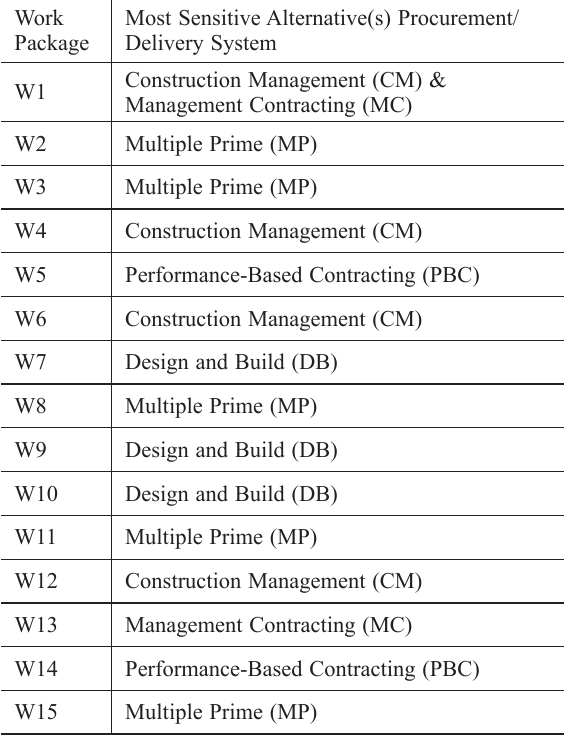
Table 5. Most important vs. most sensitive sub-criteria for all 15 work packages Work Package